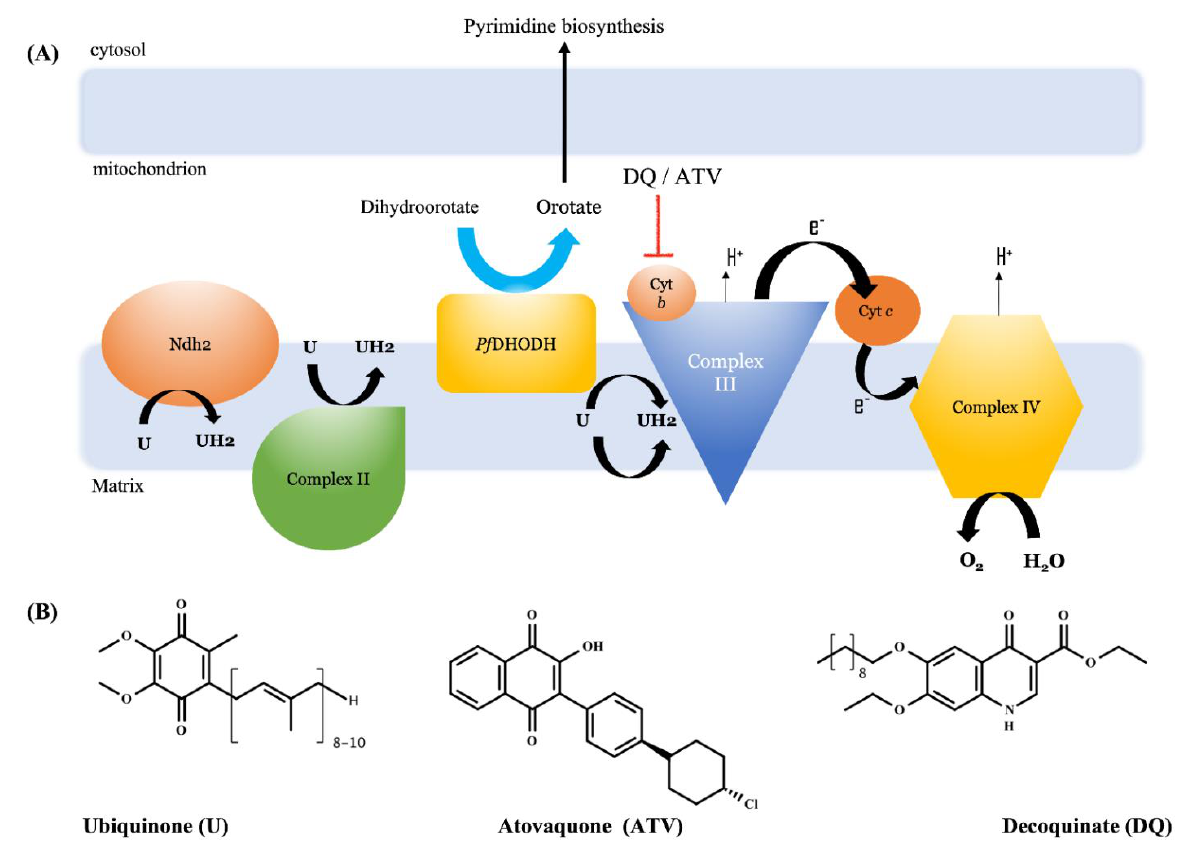
Figure 4. Overview of pyrimidine metabolism in Plasmodium parasite and its drug blockage. Panel ( A ) shows that ubiquinone is recycled by redox chemistry from the dehydrogenase enzymes’ rotenone-insensitive internal NADH dehydrogenase (Ndh2) in complex I and P. falciparum dihydrooro- tate dehydrogenase ( Pf DHODH) in complex II. Complex III is involved in pyrimidine biosynthesis and regulation of the complex IV, which is necessary for the electron transport chain. Drugs that bind to the ubiquinone-binding site of cytochrome b of the bc 1 cytochrome complex block the recovery of ubiquinone by Pf DHODH and the transfer of electrons to downstream acceptors in the complex IV. This leads to a breakdown of the mitochondrial membrane potential and the subsequent death of the parasite. Panel ( B ) shows the chemical structures of ubiquinone (U) and the antiplasmodic drugs atovaquone and decoquinate, which compete with ubiquinone for the binding site in cytochrome b (Cyt b).